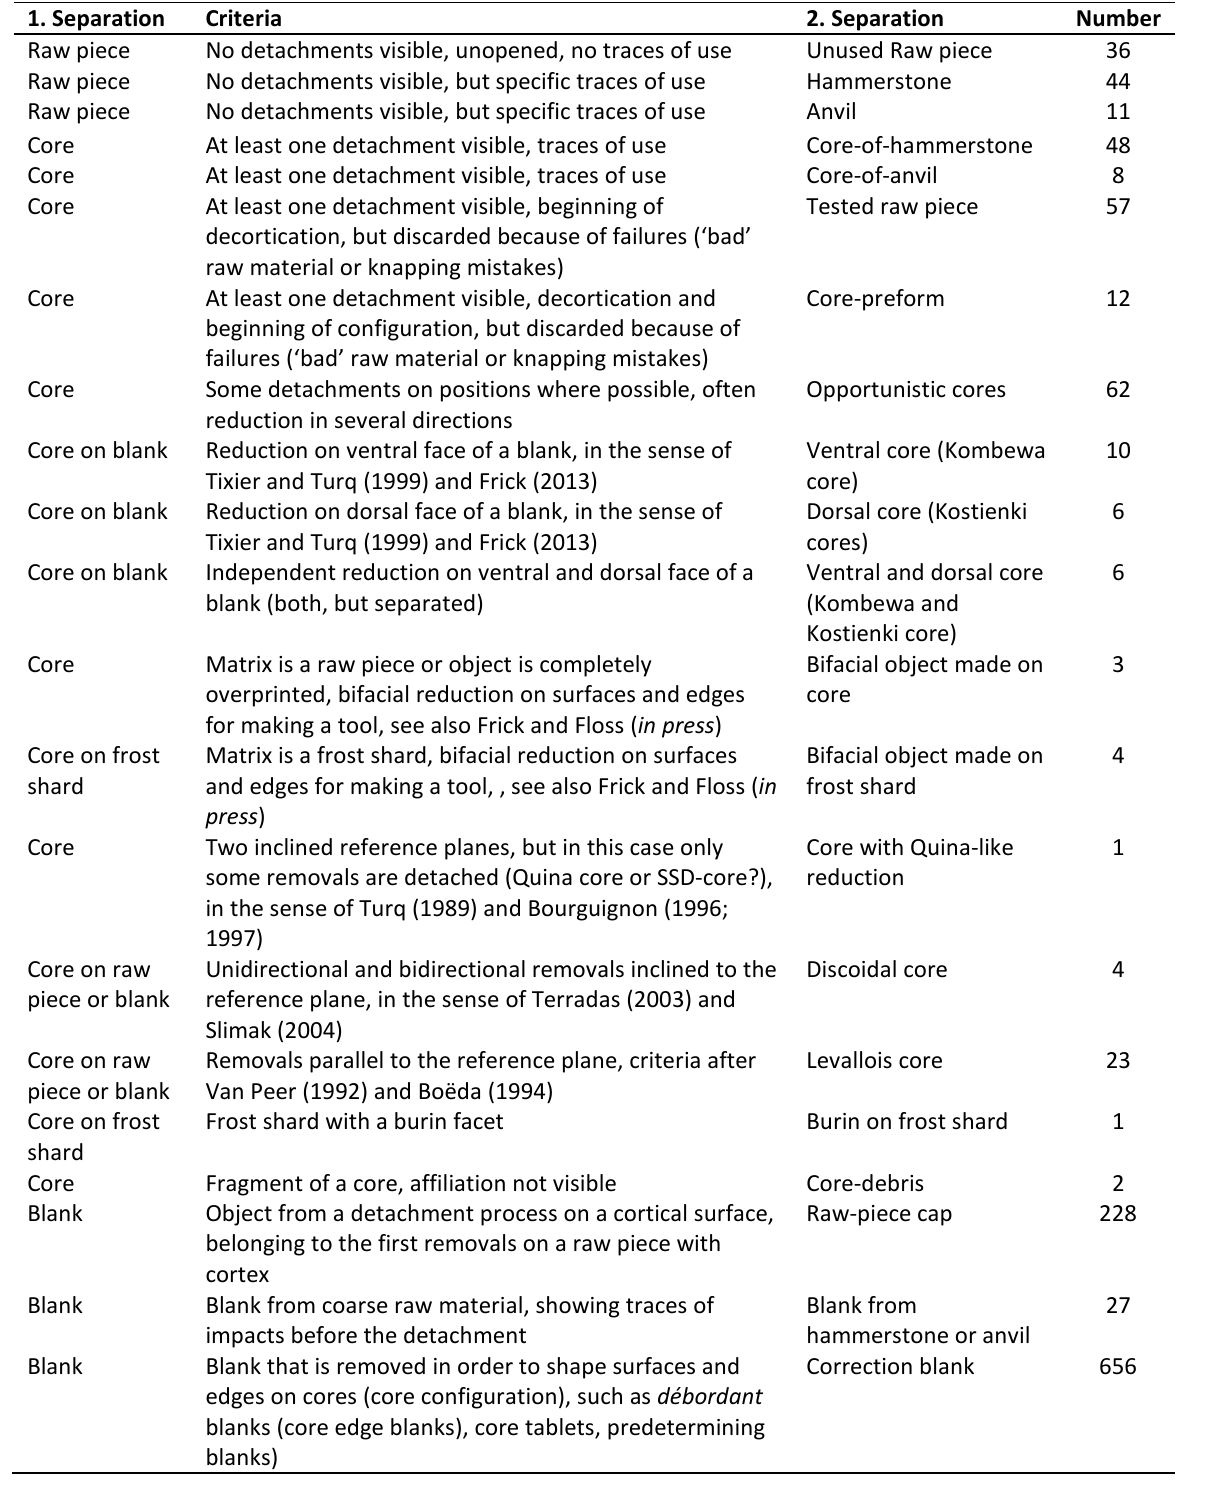
Table 1. Separation of lithic objects and number concerning all lithic raw materials from GH 3 (campaigns 2009 to